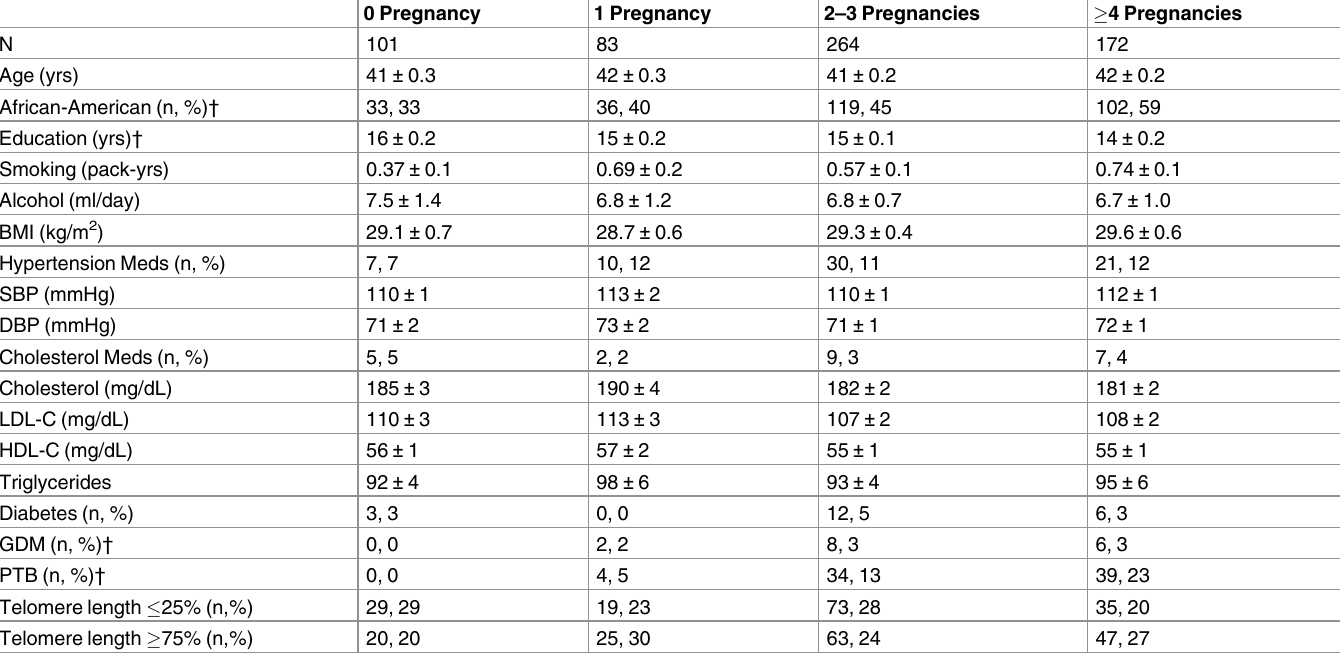
Table 2. Participant characteristics at time of telomere length measurement by gravidity group.